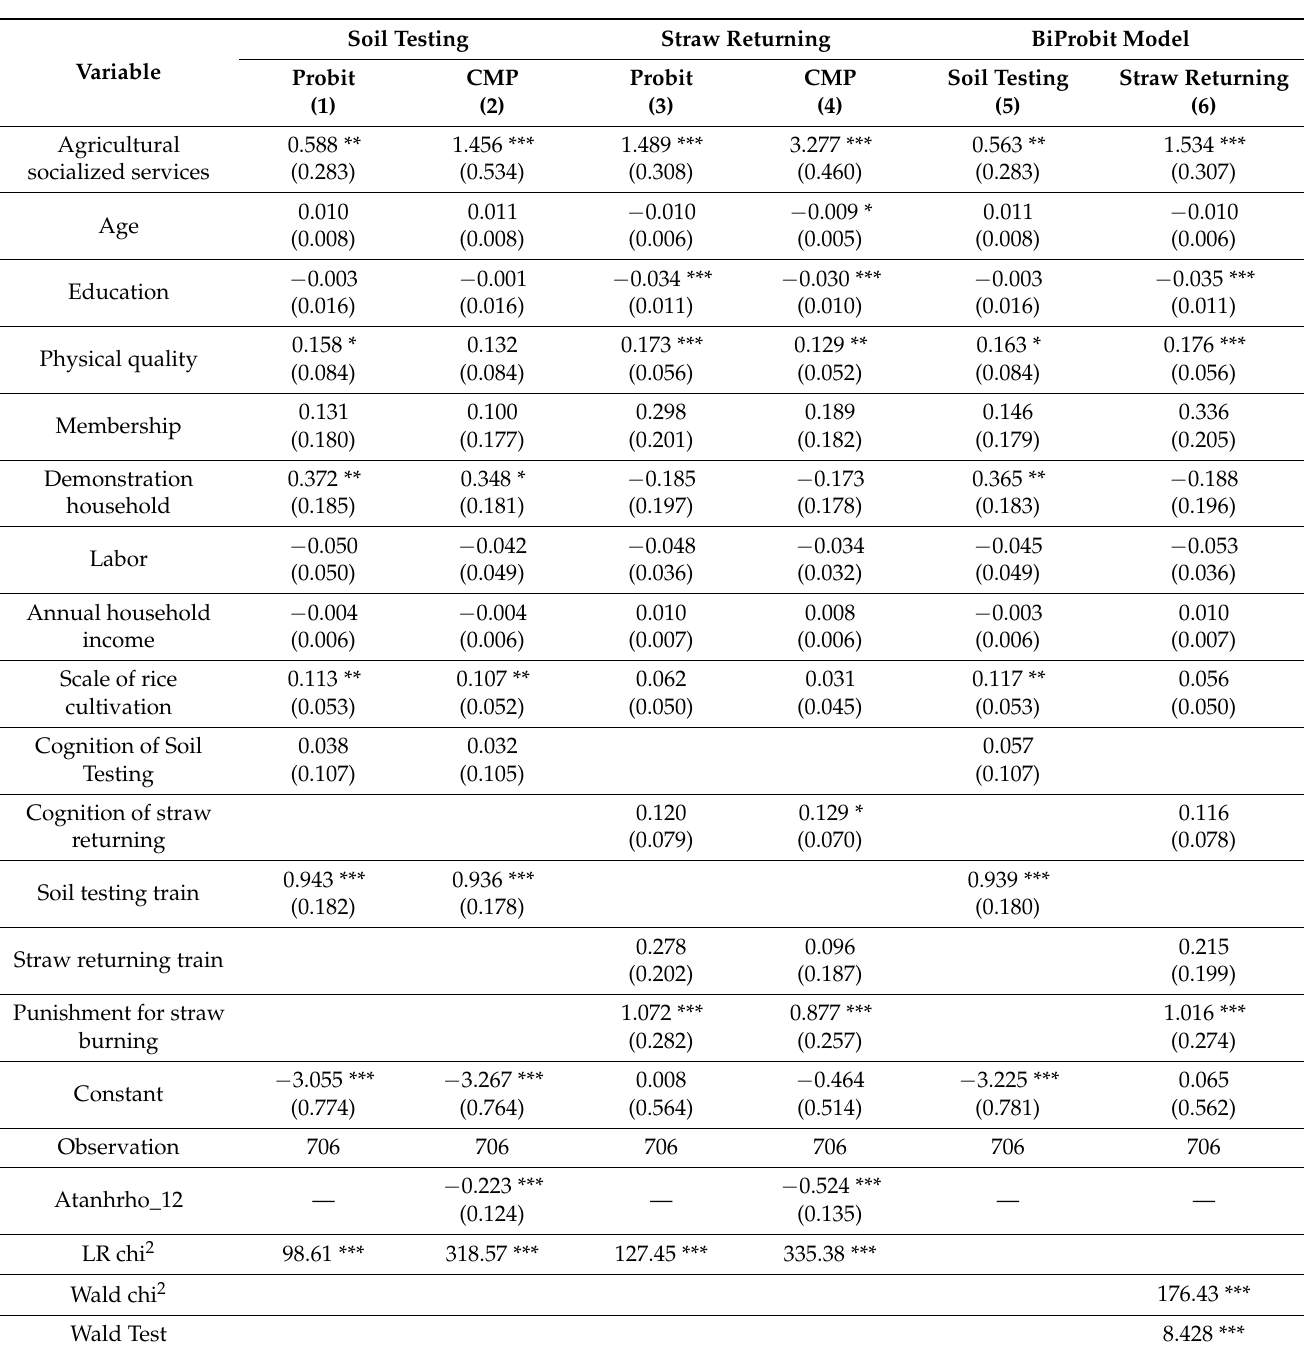
Table 2. Regression results on the impact of agricultural socialized services on the adoption of cultivated land conservation